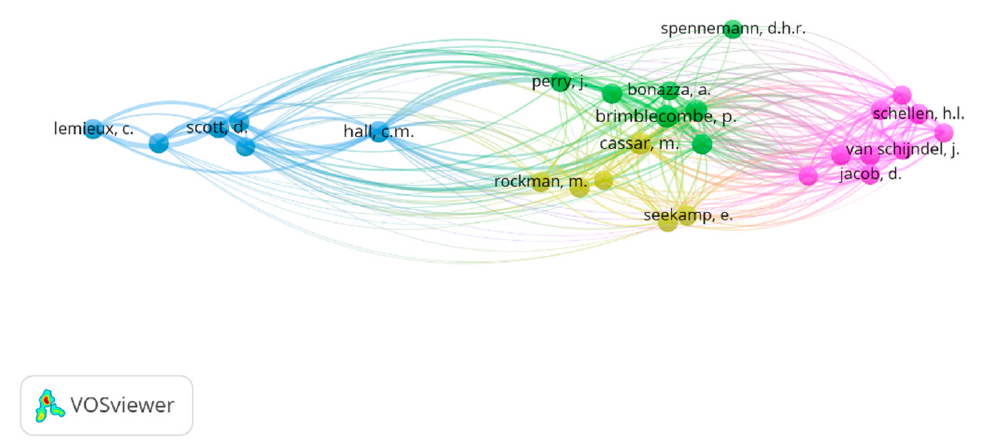
Figure 8. Author co-citation analysis (ACA). Source: own elaboration.